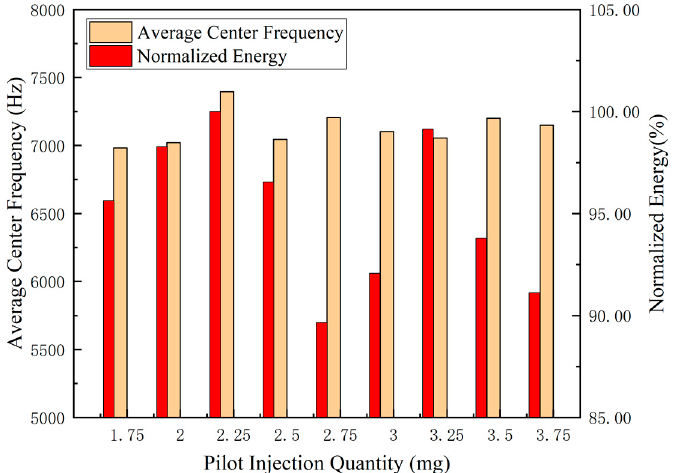
Figure 25. Average center oscillation frequency and the normalized average oscillation energy under di ff erent pilot injection quantity.